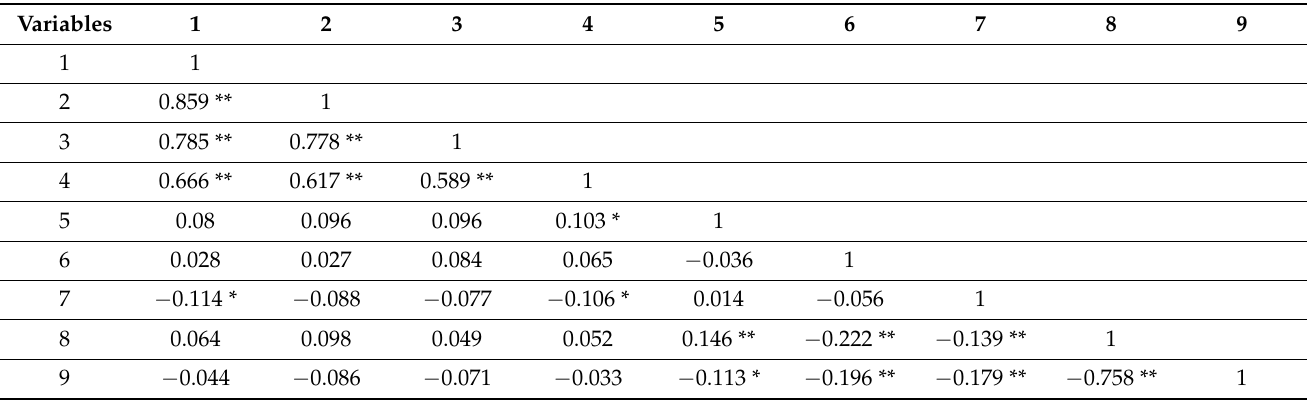
Table 3. Correlation analysis among